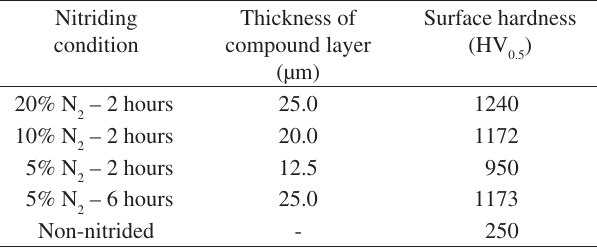
Table 1. Compound layer thickness and the respective surface hardness values for different nitriding conditions.